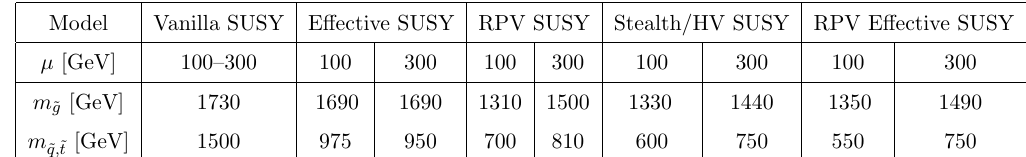
Table 2 . Observed lower limits on the mass of the gluino m ~ g and squarks m ~ q ; m ~ considered above. The limits are asymptotic in the sense that they refer to the case where all other superpartners decouple. The vanilla SUSY limits are independent on the higgsino mass for (cid:22) < 300